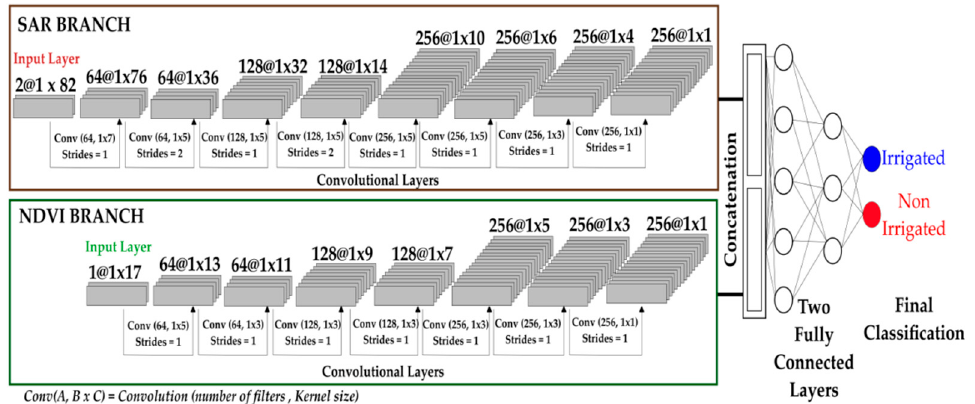
Figure 5. Architecture of the one dimensional (1D) CNN model (CNN1D) used for classification of irrigated/non-irrigated plots using SAR and optical data.